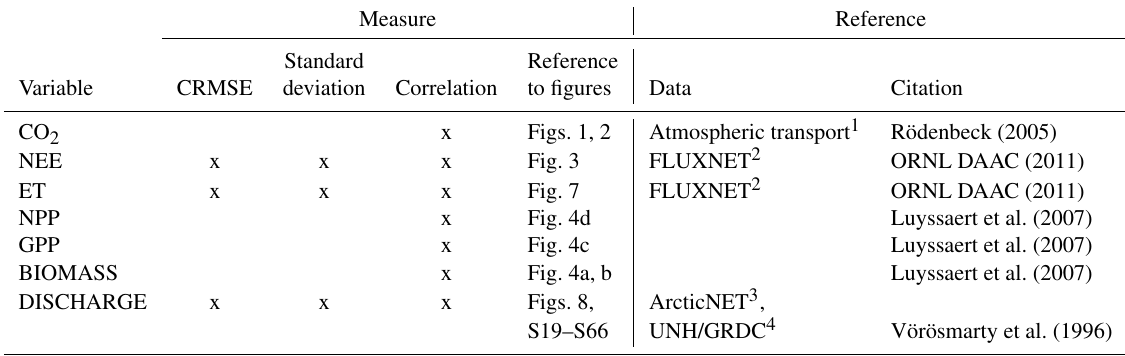
Table 2. Overview of variables and measures used for the evaluation of LPJmL4 local scale.